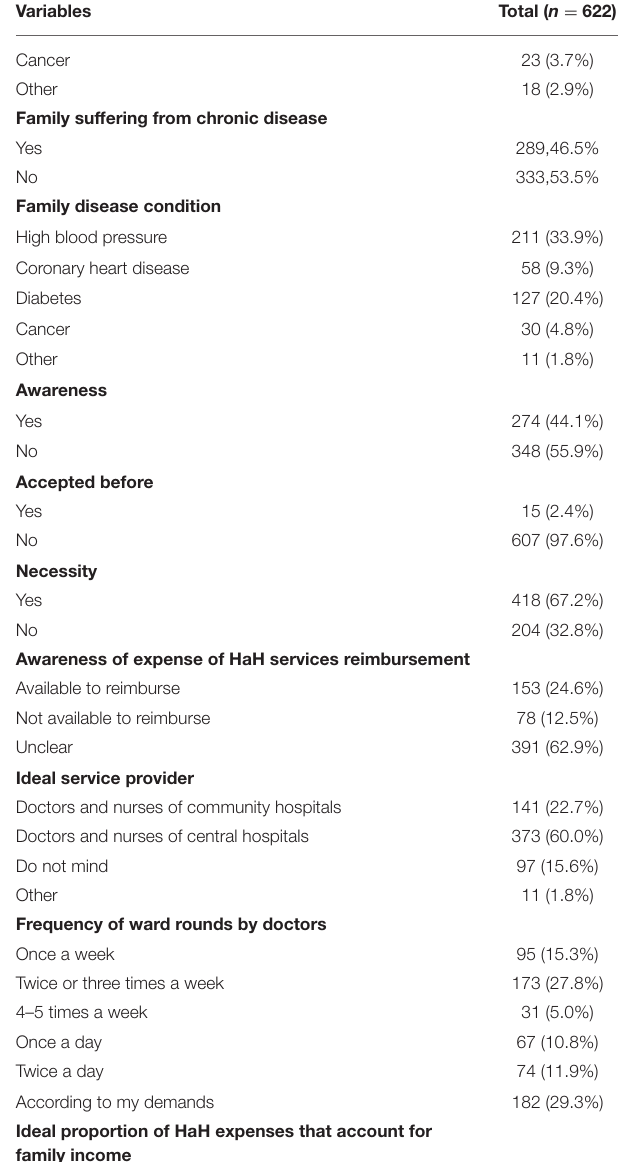
TABLE 1 | Participant characteristics, awareness of, willingness to accept, and demands regarding HaH